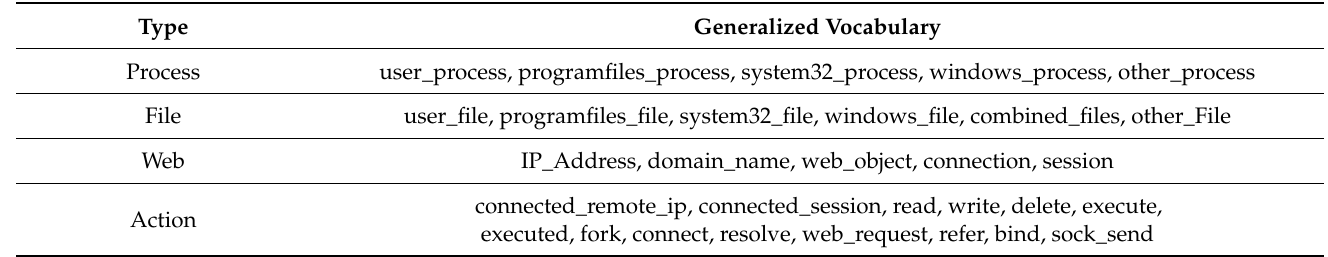
Table 1. Abstracted vocabulary set for